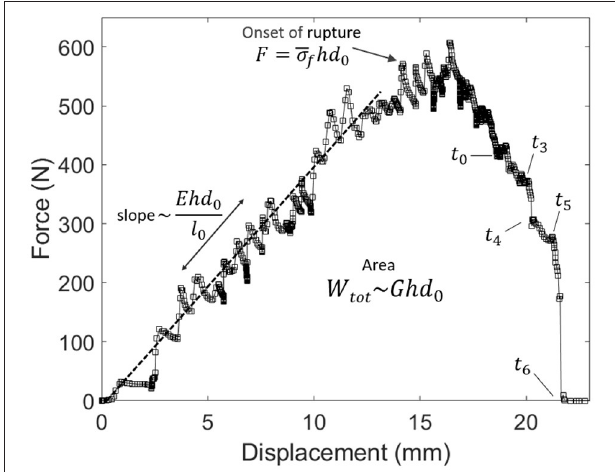
0.15 mm for h and ±